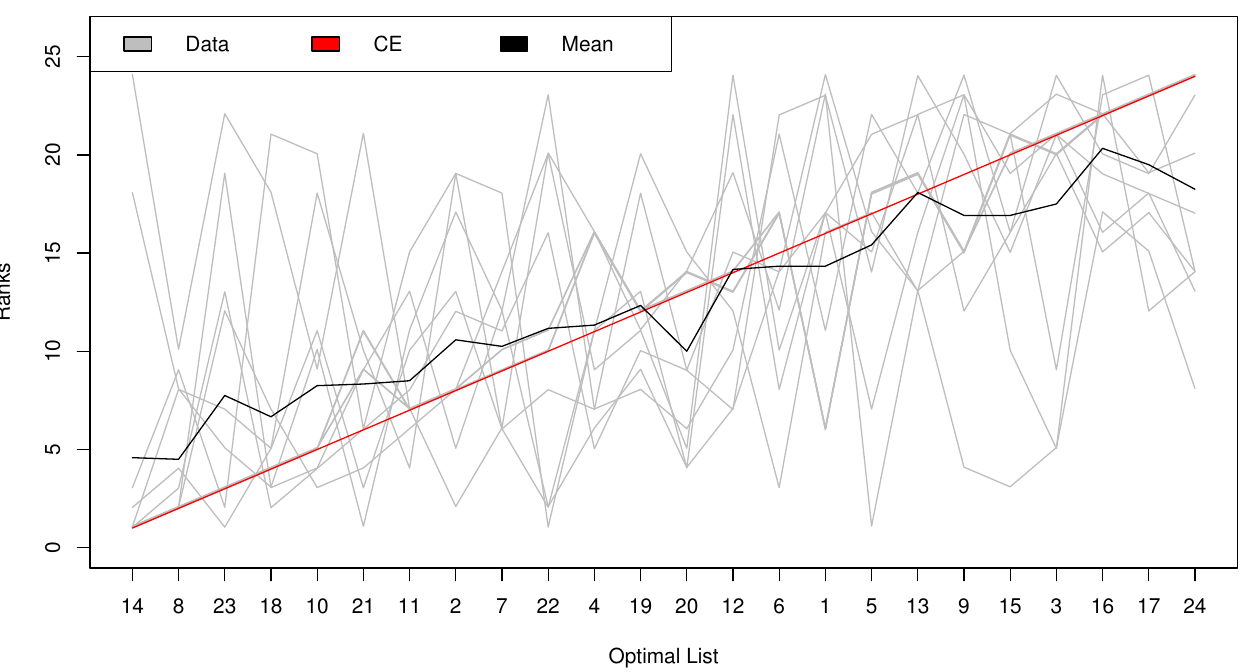
Figure 2. Rank lists of rank aggregation with the dataset “NPC” in case